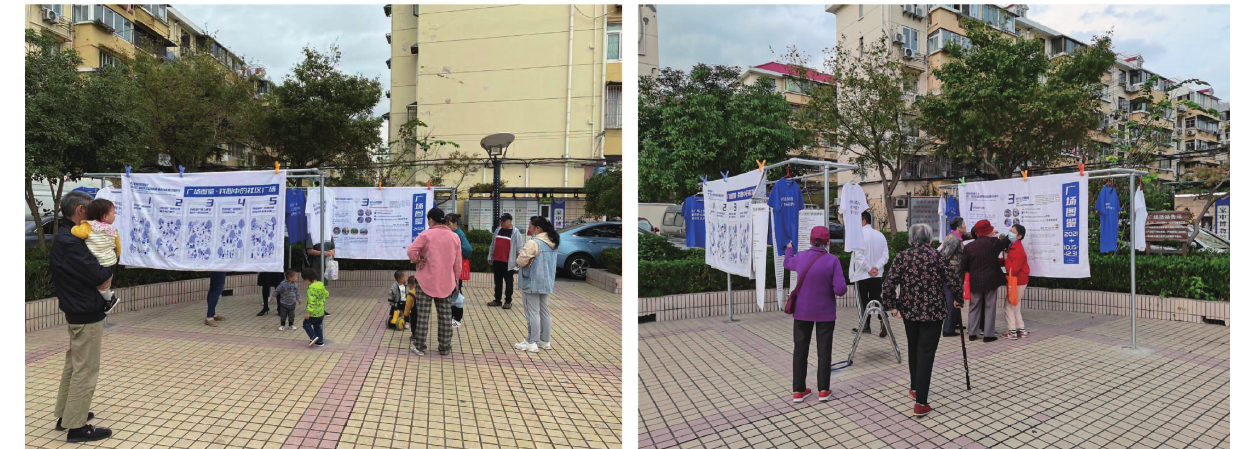
Figure 5. Community square exhibition.